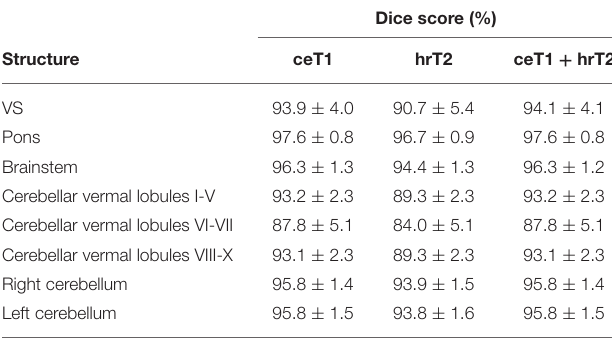
TABLE 4 | Results of the automatic segmentation of selected brain